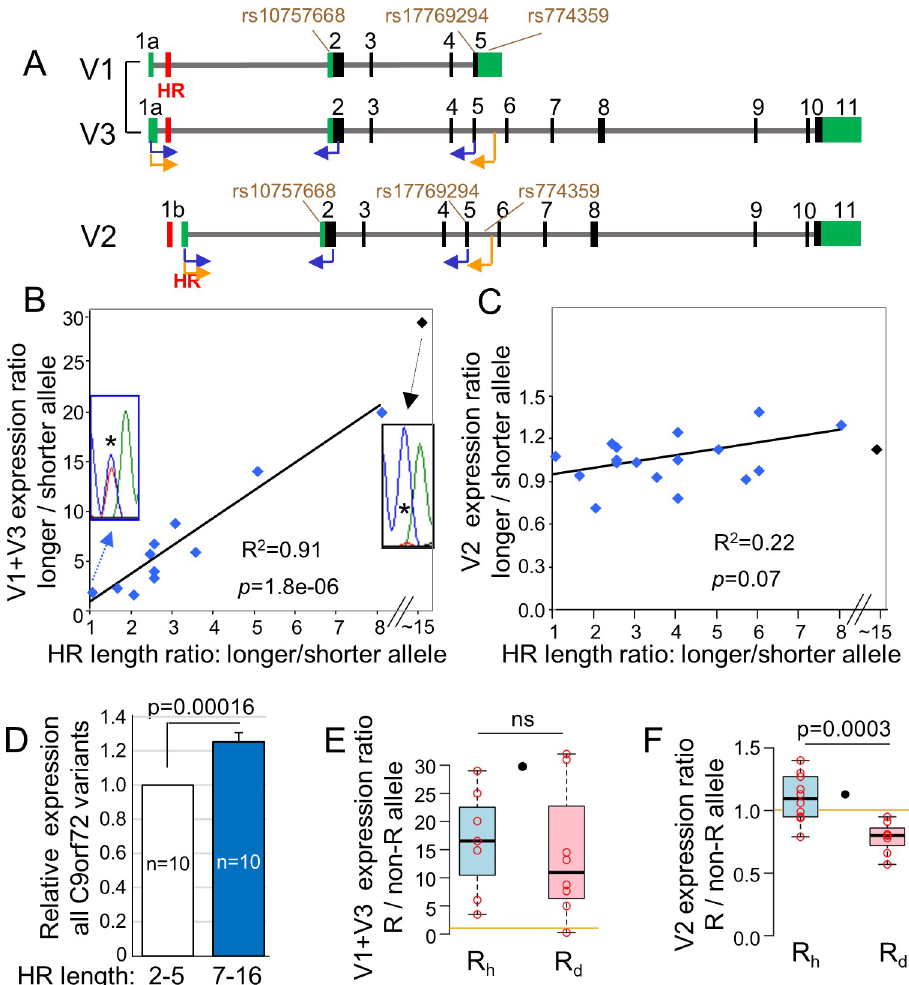
Fig 2. Association between HR length and C9orf72 gene expression. (A) Schematic illustration of C9orf72 variants analysis. Black and green blocks represent translated and untranslated exonal regions, respectively. RT-PCR primers (arrows) and SNPs used for analyses are indicated. (B) Scatterplot showing significant positive correlation between V1 +V3 expression level and HR length in normal and intermediate fibroblasts. The x -axis represents the HR length ratio between the longer to the shorter allele. The y -axis represents the expression ratio between the longer and the shorter allele. The line shows the best-fit regression line for the normal alleles. The intermediate R 30 K 2 was not included in the equation due to its uncertain HR length. The inserts show the C/T heterozygous SNP rs10757668 (asterisk) within the RT-PCR amplified products of F 2 K 2 (HR ratio of 1) and R 30 K 2 (HR ratio of ~15). Blue peaks of the C nucleotide represent the F and the R 30 alleles, and red peaks of the T nucleotide represent the K allele. (C) Scatterplot showing non-significant correlation between V2 expression level and HR length in non-mutated fibroblasts. The x - and y -axes are as in (B). (D) The overall allelic C9orf72 expression from R h alleles that carry 7–16 repeats compared to complementary F, K and P alleles, which carry 2–5 repeats. The allelic ratio determined by the analysis of heterozygous SNPs along exons 2, 5 and 11 (S1 Table, #12, 24 and 38). Data presented as mean ± SEM. (E , F) Boxplots showing the relative expression from R h allele with 7–16 repeat units (blue box) and from R d allele with expanded HR (pink box), relative to the complementary shorter alleles. The R 30 allele is depicted in black circle between the R h and the R d boxes. (E) V1+V3, (F) V2. Boxplots show median and quartiles and whiskers are 1.5 times the interquartile range. The orange horizontal line delineates a ratio of 1 and represents the non-R allele expression level. ns: